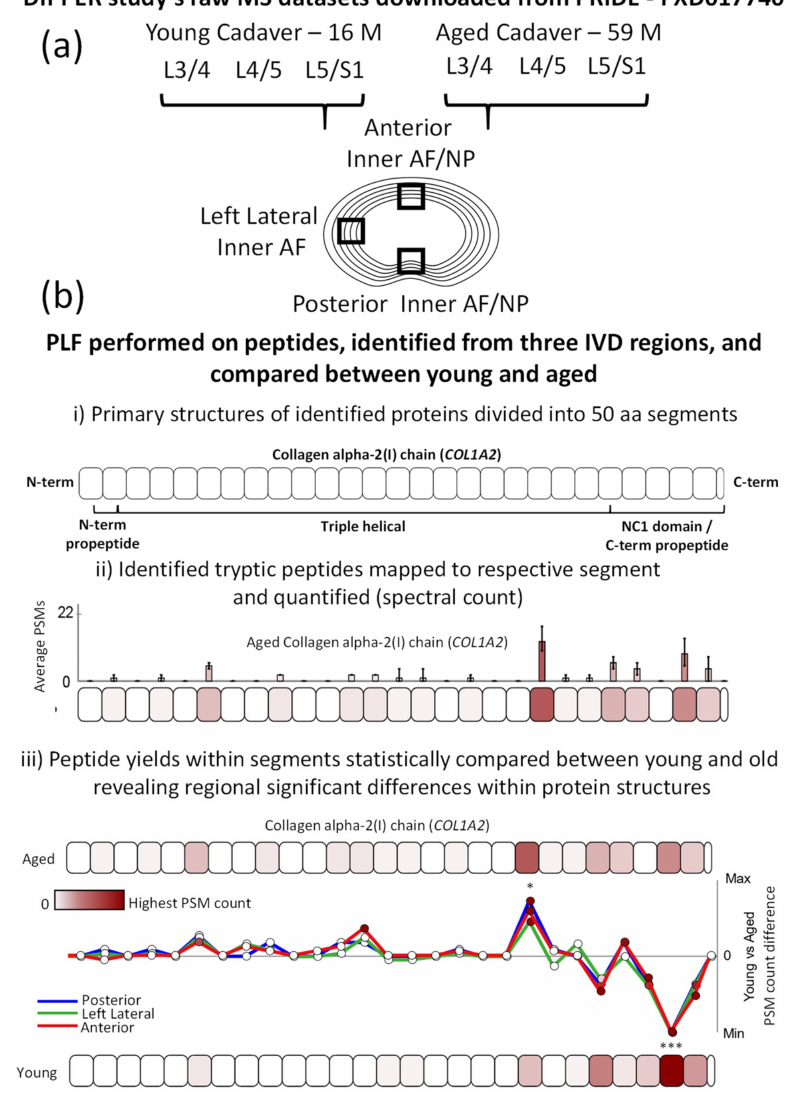
Figure 1. Experimental design for the application of PLF to three distinct regions of young and aged IVDs. ( a ) Raw LC–MS/MS datasets (from two males, one young [16 years old] and one aged [59 years old]), corresponding to the posterior inner AF/NP, left lateral inner AF and anterior inner AF/NP regions of the L3/4, L4/5 and L5/S1 lower lumbar IVDs were downloaded from the PRIDE repository (PXD017740) [13]. ( b ) After MS/MS peptide identification, the MPLF webtool [25] was used to perform PLF on the identified peptides and compare peptide yields across protein structures between young and aged discs—three vs. three discs for anterior and left lateral datasets and three vs. two discs for posterior datasets (the young anterior L4/5 disc was omitted from the analysis due to the insufficient number of identified peptides for PLF analysis). As previously described [25], (( b ), i) proteins were divided into 50-amino acid (aa)-sized segments; the collagen I α 2 chain ( COL1A2 ) is shown here as an example. (( b ), ii) Peptides were mapped to their respective segments, summed, normalised between aged and young groups based on the median whole protein spectrum count and averaged for each group (average peptide spectrum match [PSM] count per segment). (( b ), iii) Peptide yields in each segment were statistically compared between young and aged IVDs using an unpaired, Bonferroni-corrected, repeated-measures ANOVA (* p ≤ 0.05; *** p ≤ 0.001). To visualise these differences along the protein structure, average PSM counts per segment in the young group were subtracted from those in the aged one and compared between posterior, left lateral and anterior IVD